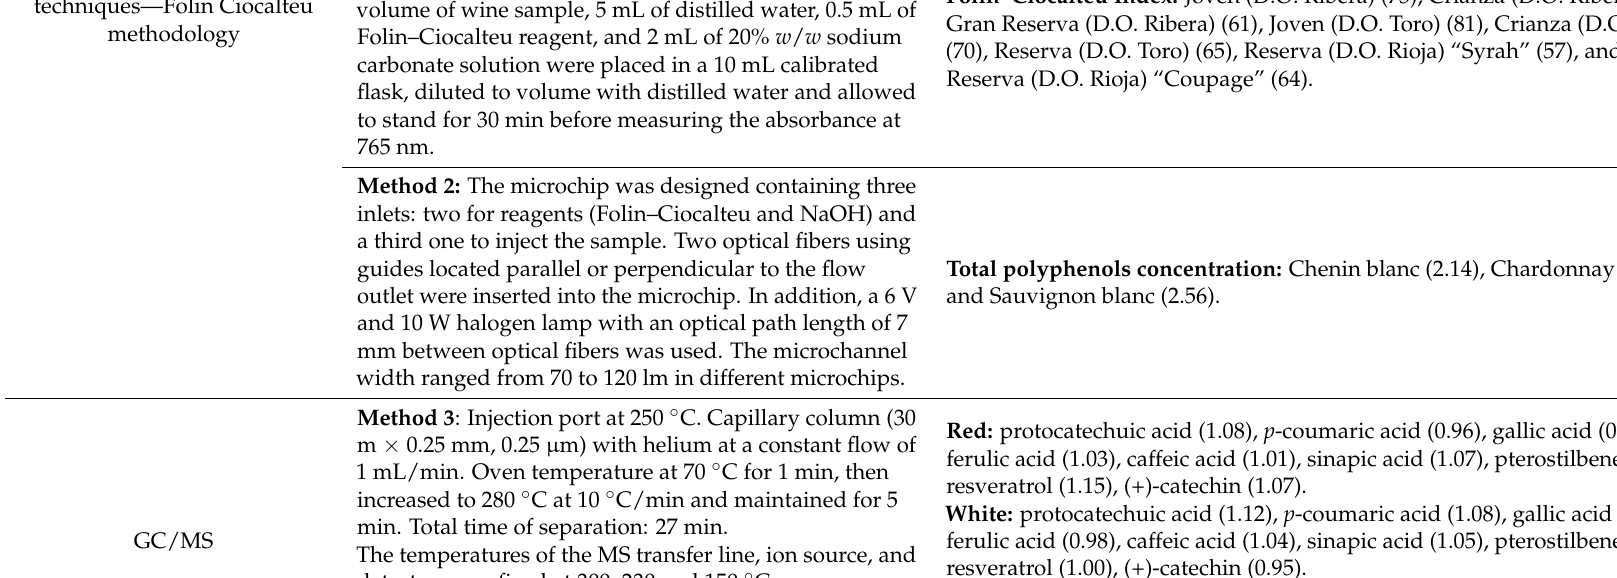
Spectroscopic techniques—Folin Ciocalteu